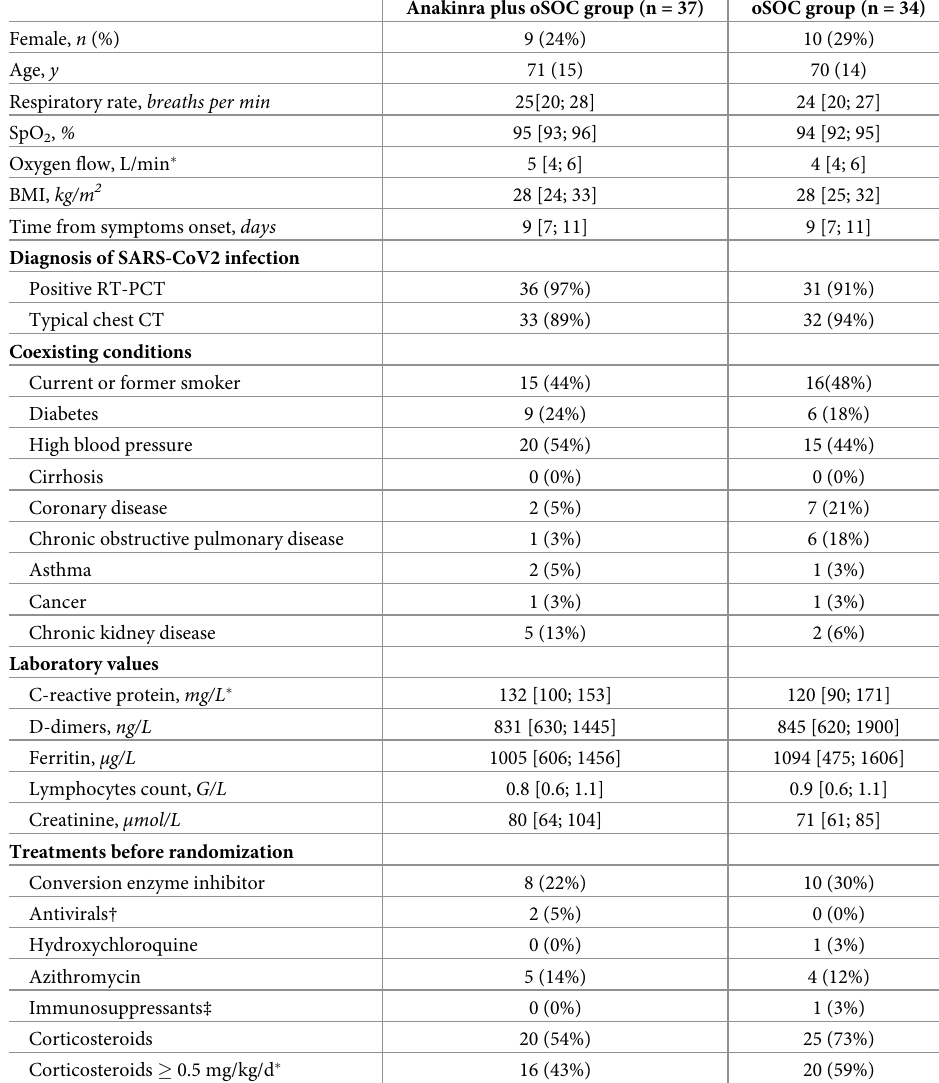
Table 1. Baseline characteristics of participants.